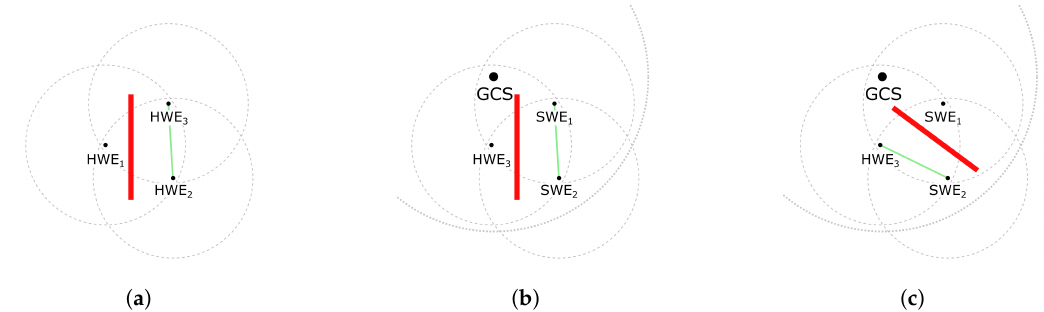
Figure 12. Scenarios showing the system behavior during message exchange under the presence of a communication obstacle (red). In all cases, each entity tries to send a message to the remaining two. The messages are exchanged only between entities that have mutual obstacle free connectivity (green lines). The rest of the messages are dropped either directly by the effect of the obstacle in the HW scenario or by the network simulation within the GCS in the MR